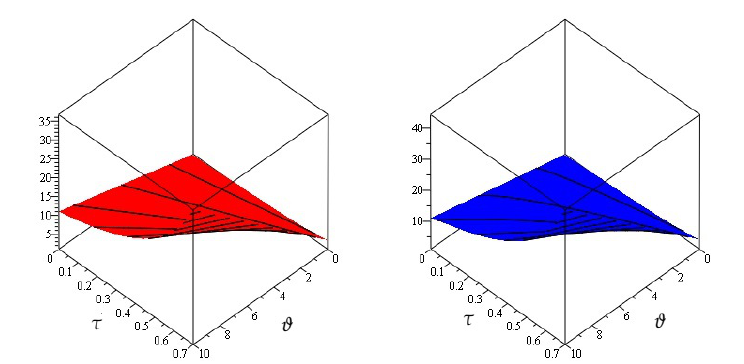
Figure 4. Exact and analytical solution of ν ( ϑ , ζ , z , τ ) at (cid:36) = 1 and 0.8 of Example 2.